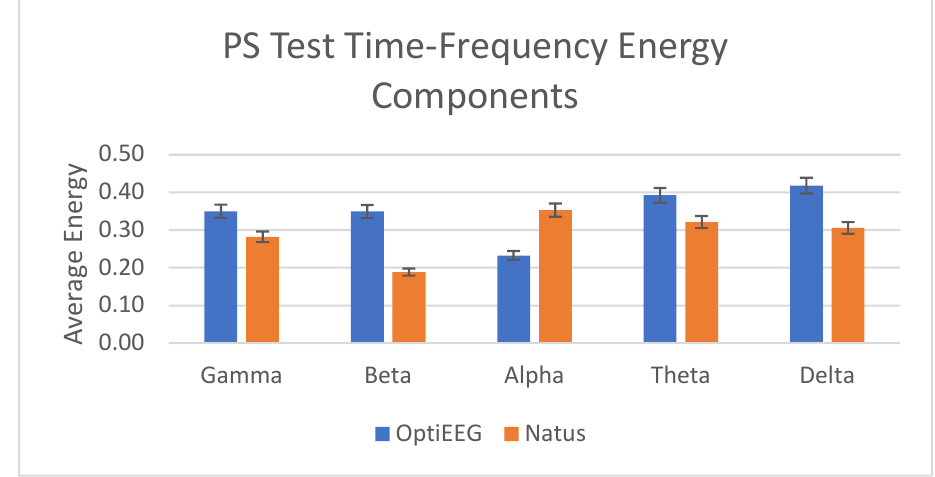
Figure 15. Power of time–frequency components for PS test.